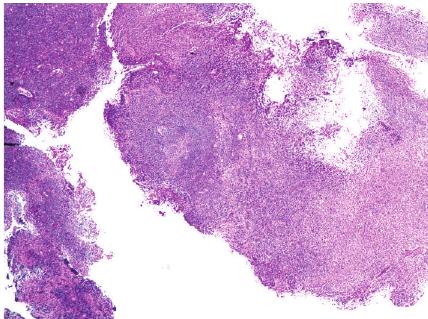
Figure 1: Low magnification-lymph node with focal well circum- scribed paracortical necrotizing lesions.